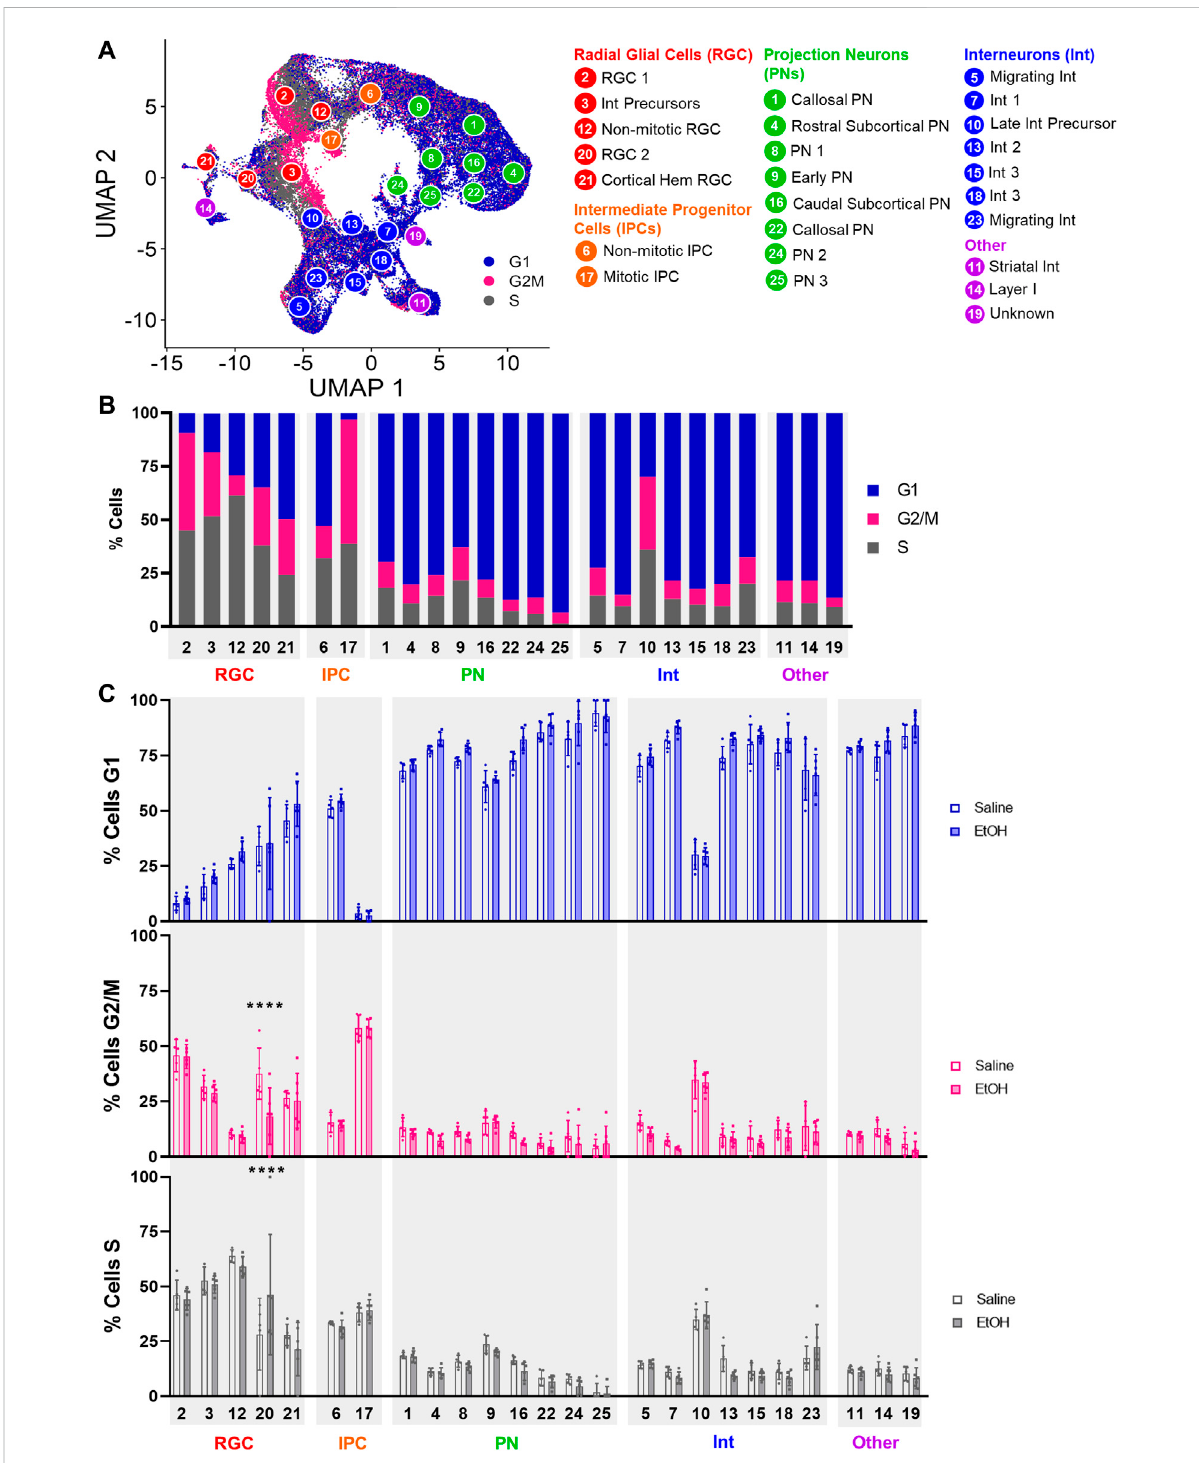
FIGURE 3 Percentage of cells in cell cycle stages. (A) UMAP overlaid with the cell cycle stage for each cell. (B) Bar graph of the percentage of cells in each cell cycle stage across all samples. (C) Bar graph of the percentage of cells in each cell cycle stage comparing Saline and EtOH. ****: p <